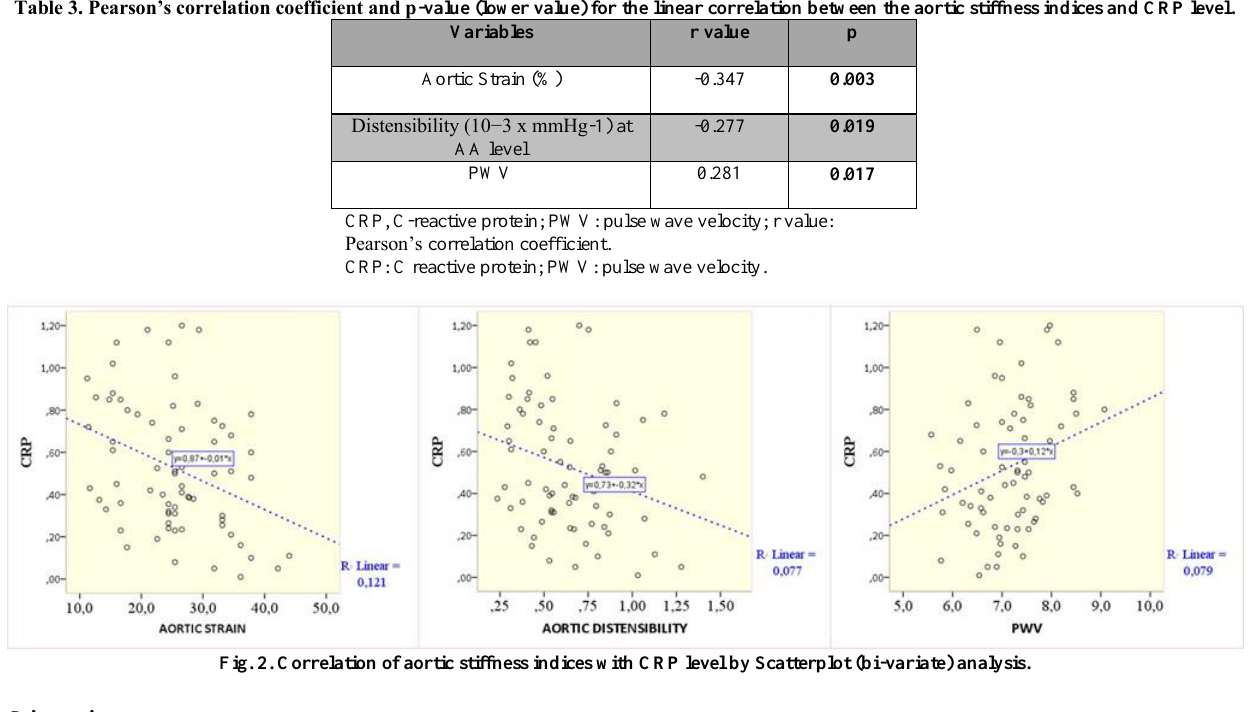
Fig. 2. Correlation of aortic stiffness indices with CRP level by Scatterplot (bi-variate)